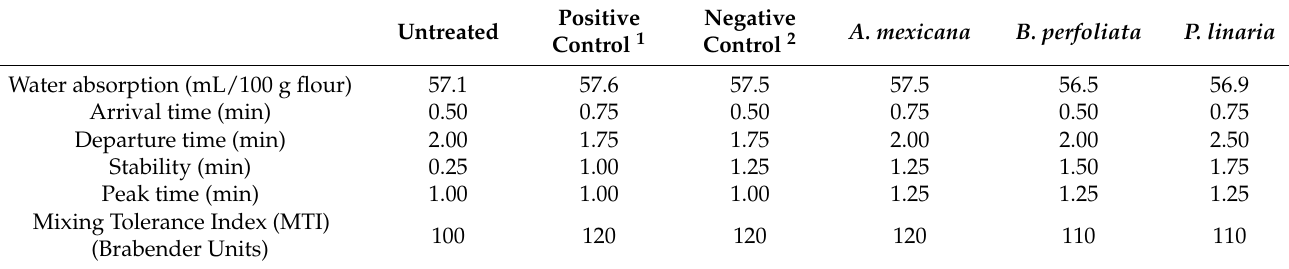
Table 7. Farinograph diagram parameters of the flour obtained from wheat treated with the essential oils. Untreated